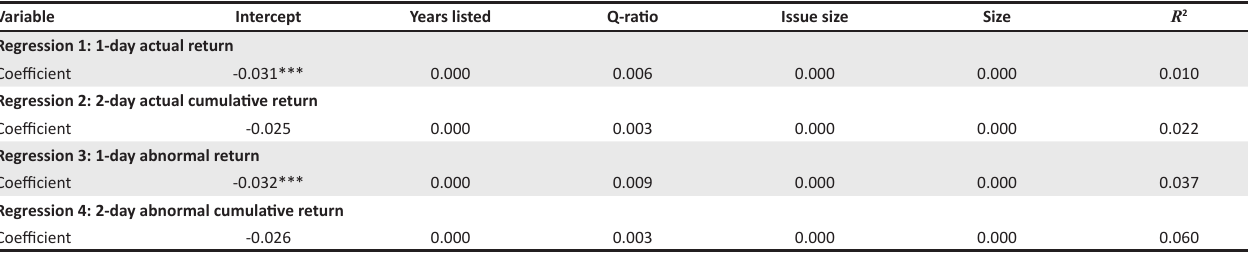
TABLE 5: Event study regression analysis.